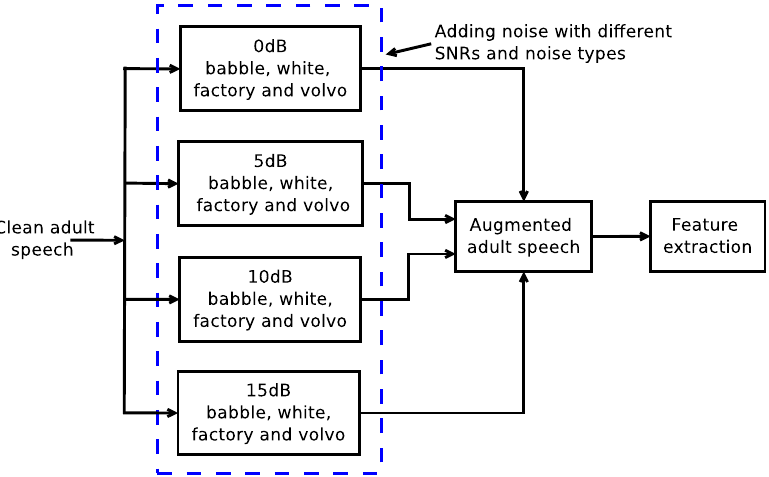
Figure 2. A block diagram of the data augmentation